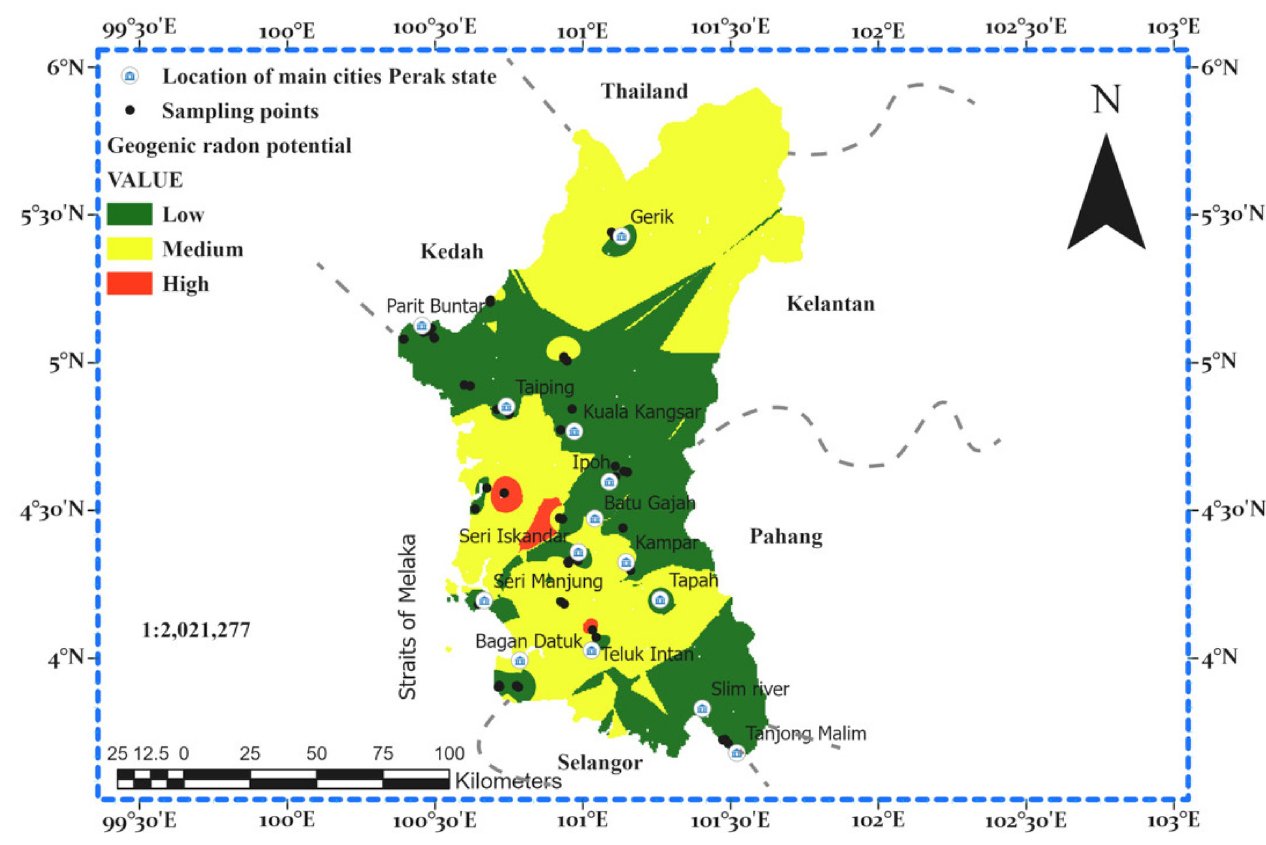
Fig 9. Geogenic radon potential map of Perak state Malaysia.